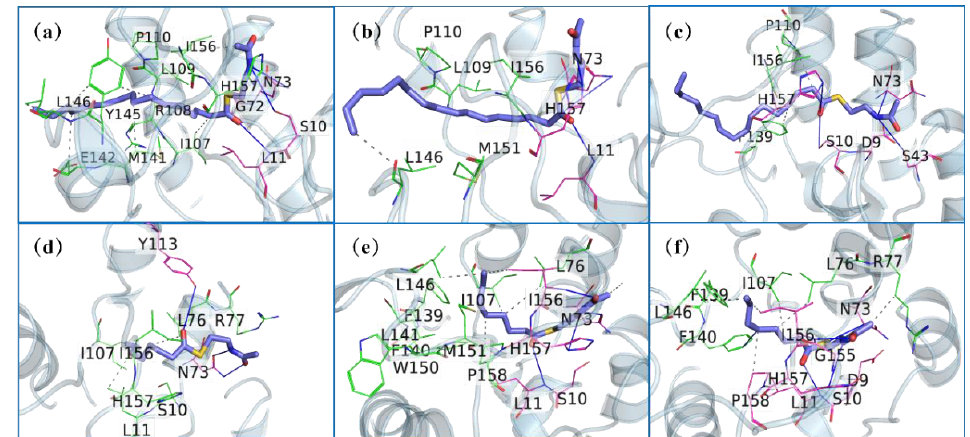
Figure 6. Key residues of hydrogen bonds and hydrophobic interactions of the six complexes. The key residues for the formation of hydrogen bonds with the acyl substrate C8/C16-SNAC (blue-purple stick) for each of the six proteins are shown as pink lines, and bond formation is shown as solid lines. The key residues for hydrophobic interactions are shown as green lines, and bond formation is shown as dashed lines. ( a ) ‘TesA_C16-SNAC, ( b ) ‘TesA E142D/Y145G _C16- SNAC, ( c ) ‘TesA M141L/E142D/Y145G _C16- SNAC, ( d ) ‘TesA_C8- SNAC, ( e ) ‘TesA E142D/Y145G _C8-SNAC, ( f ) ‘TesA M141L/E142D/Y145G